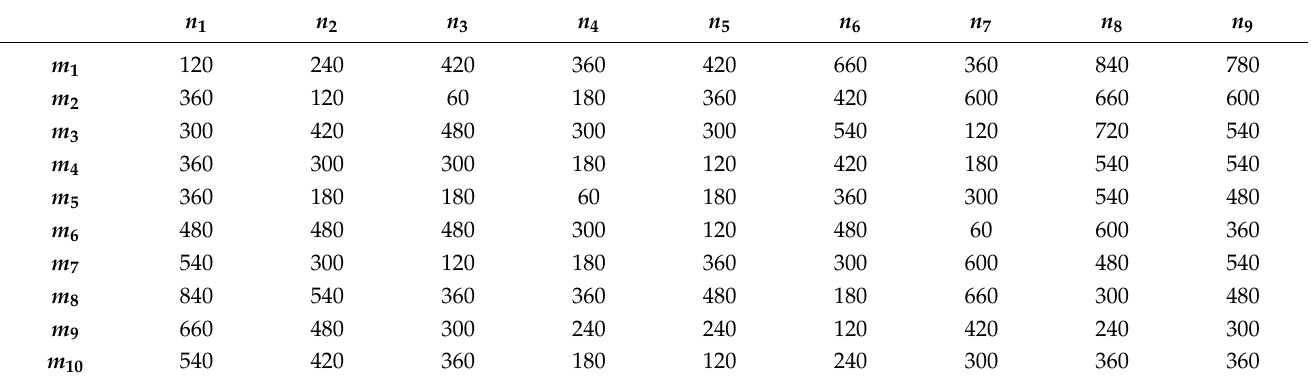
Table 4. Distance between suppliers and recipients